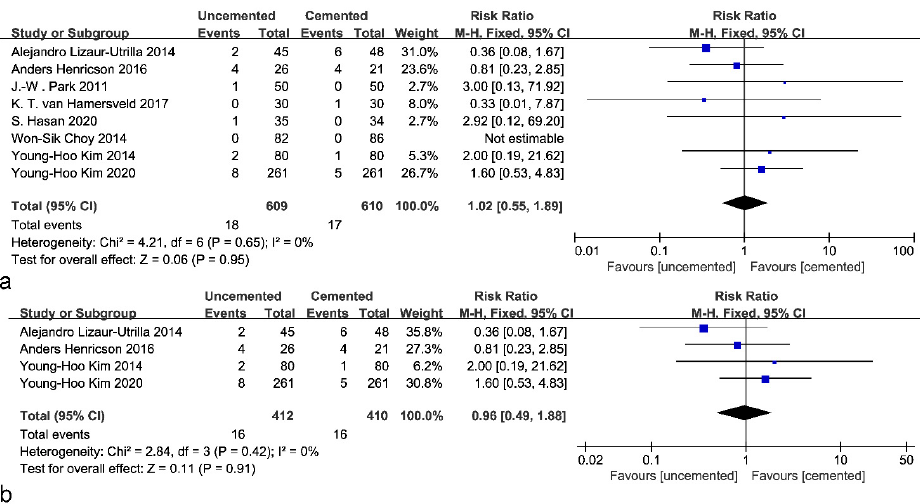
Figure 6. Forest plot of revisions. ( a ) Forest plot of revisions (without age limit) [23,25–31]. ( b ) Forest plot of revisions in young patients [26–28,31].